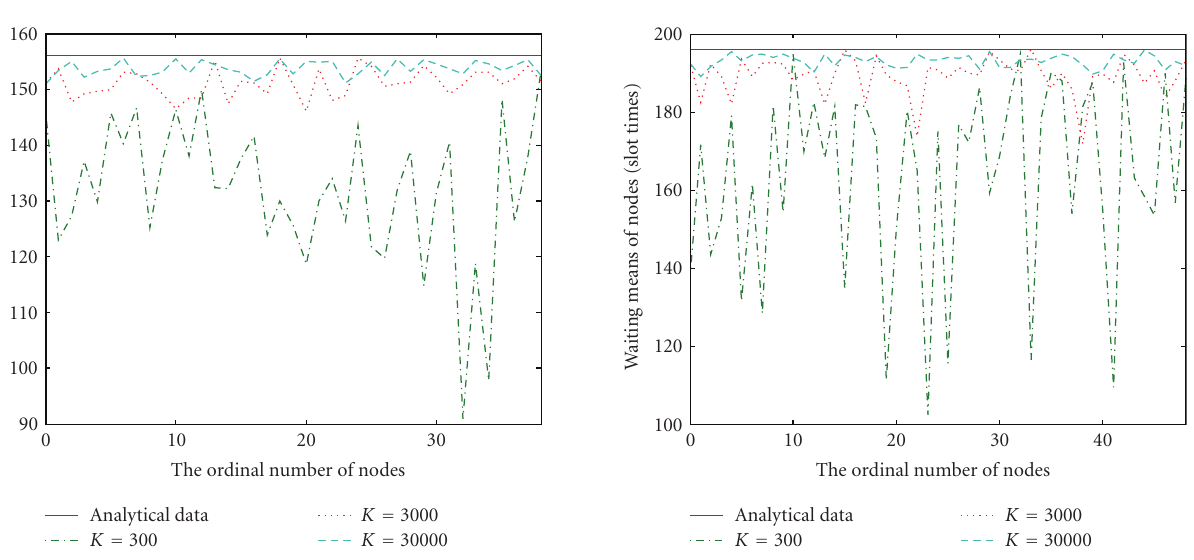
Figure 2: Waiting means of 40-node optical TDMA networks.